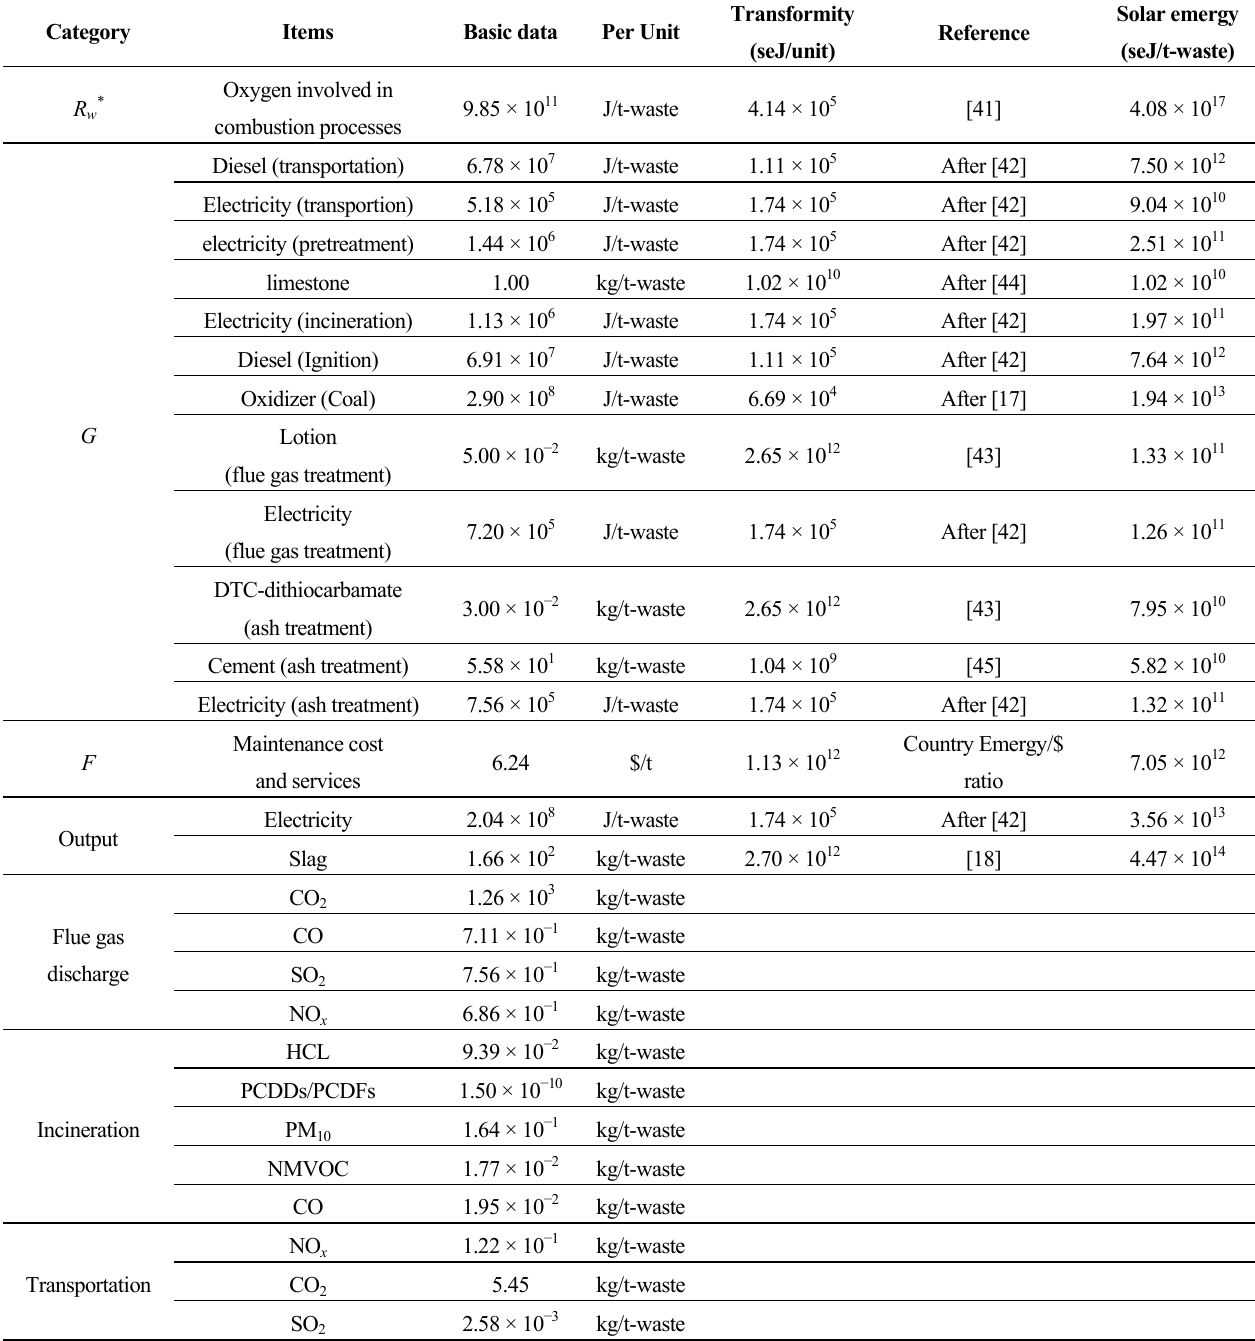
Table 3. The emergy analysis table of fluidized bed